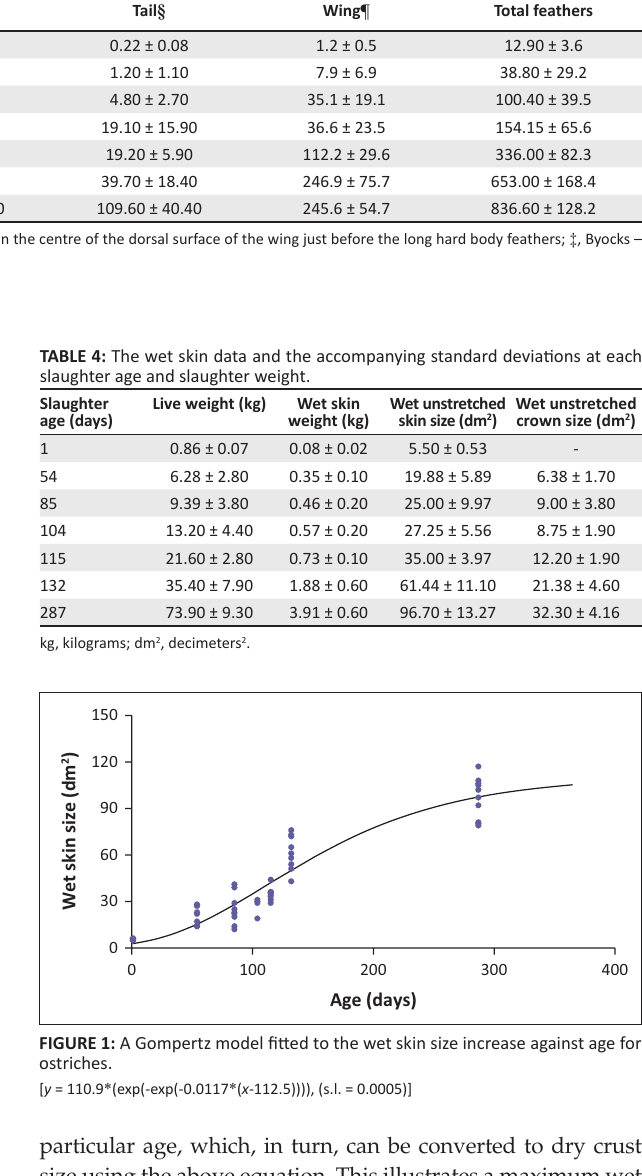
TABLE 2: The shaft diameter of the wing feathers and the feather weight (dry matter basis) at each region, and the accompanying standard deviations for every slaughter age. Age (days) Average wing shaft diameter (mm)